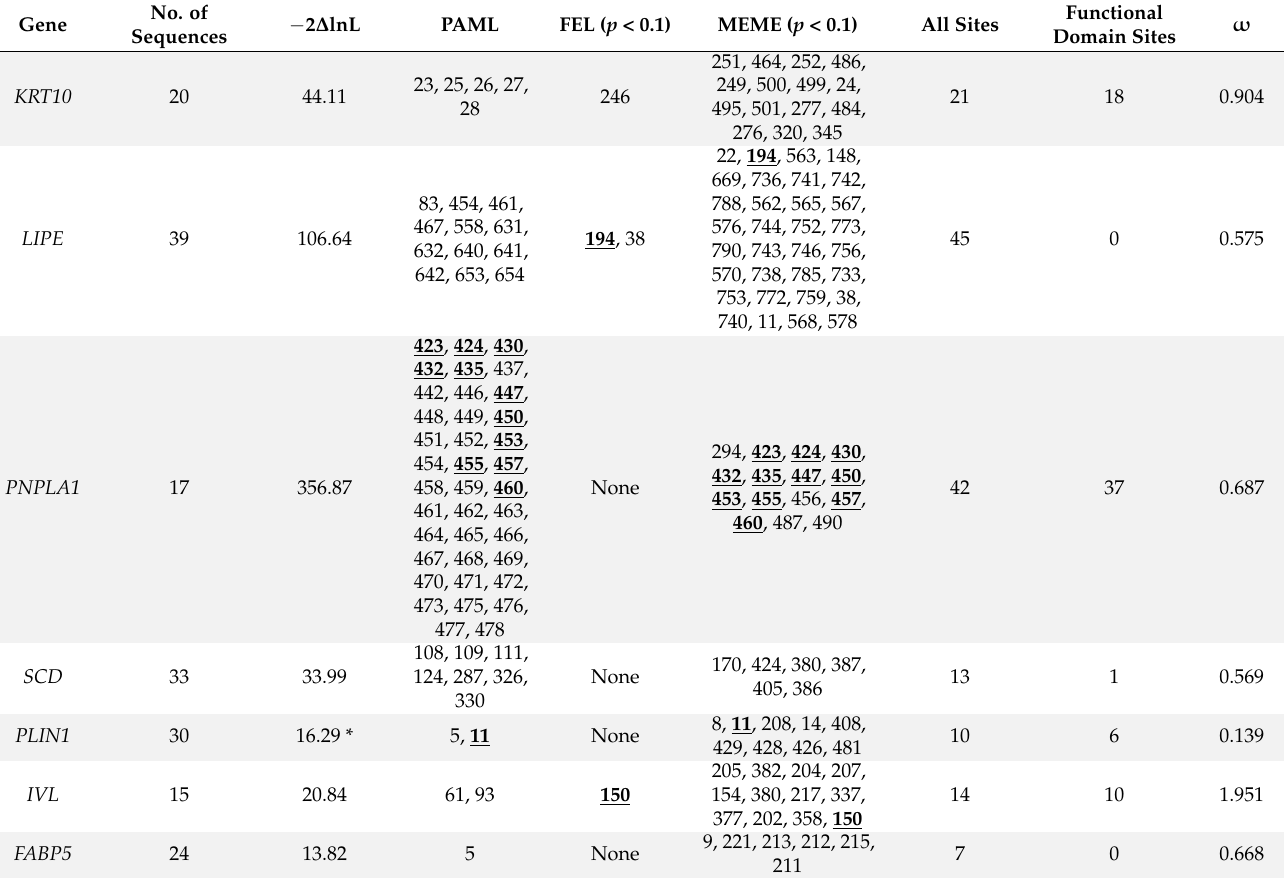
Table 1. Positive selection at amino acid sites of seven candidate genes in domestic pigs.